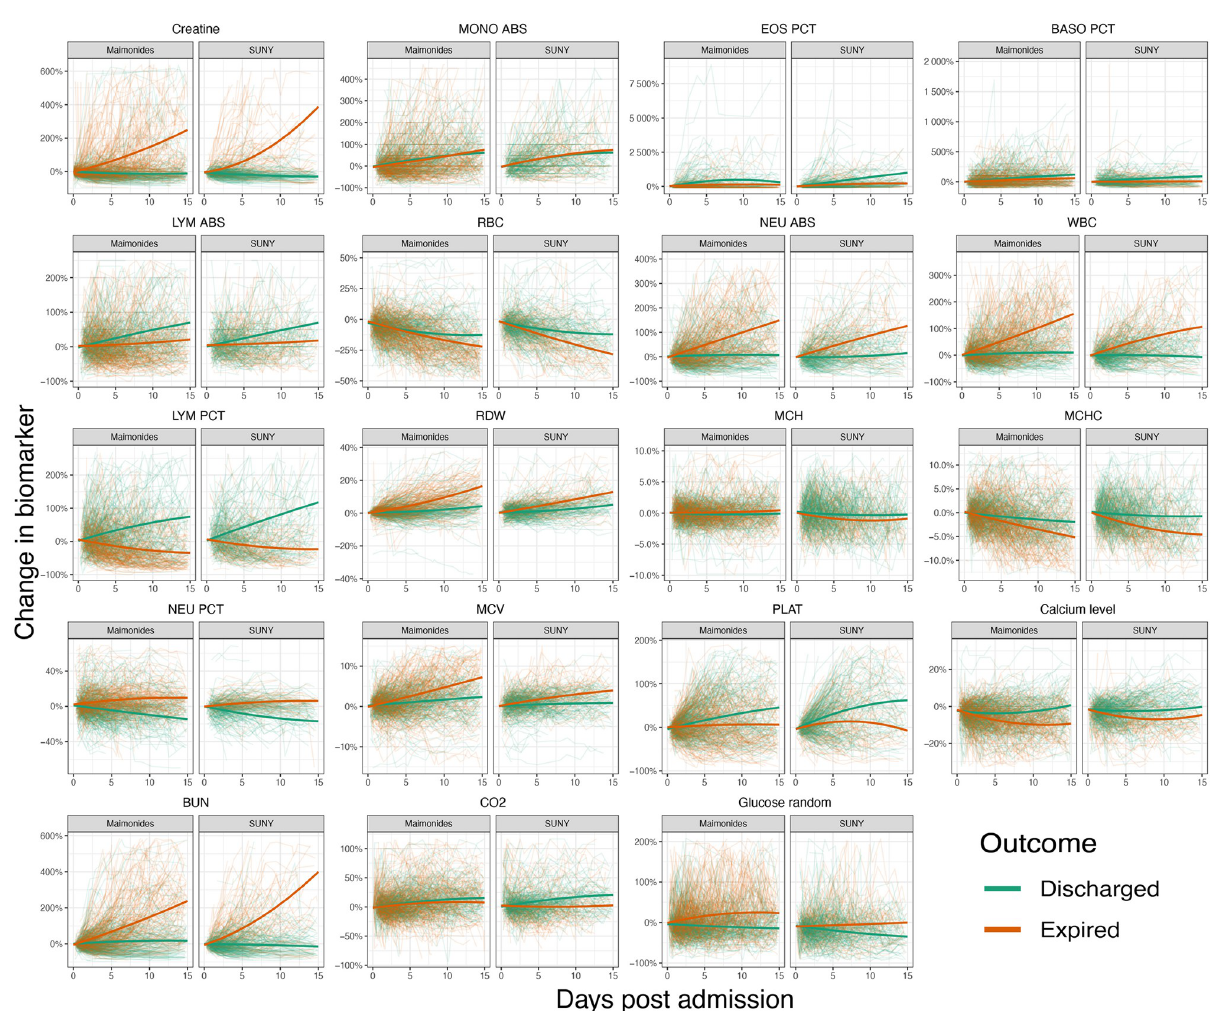
Fig 3. Comparing time trends in laboratory values across hospitals. The horizontal axis shows the days post admission and the vertical axis shows the percentage change in biomarker values from their initial values. Each panel displays trends for an individual biomarker; within the subpanels of each of these, we show the results for each of the hospitals. Individual graphs show the dynamics of the individual patients’ laboratory values (thin coloured lines) and the time trends (thick coloured lines) estimated assuming a quadratic regression function. Line colouring indicates the outcome of an individual patient (thin lines) or overall group being considered for regressions (thick lines). Note that for plotting we only display data up until day 15 post admission, since, after this point, there were relatively few patients still hospitalised.